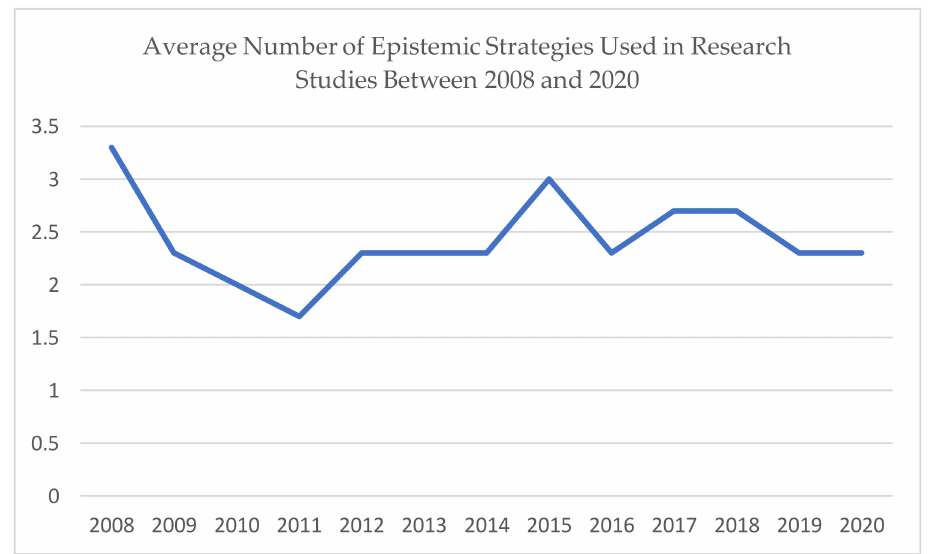
Figure 3. Average Number of Epistemic Strategies Used in Research Studies between 2008 and 2020.